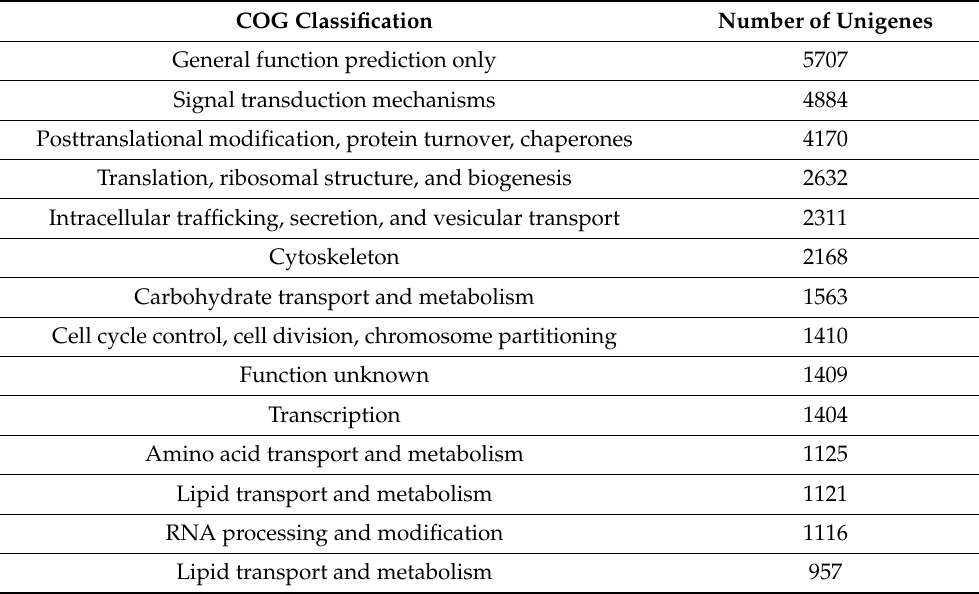
Table 1. The table represents clusters of the orthologous group (COG) classifications. In 25 categories of COG classification, a total of 36,681 unigenes were